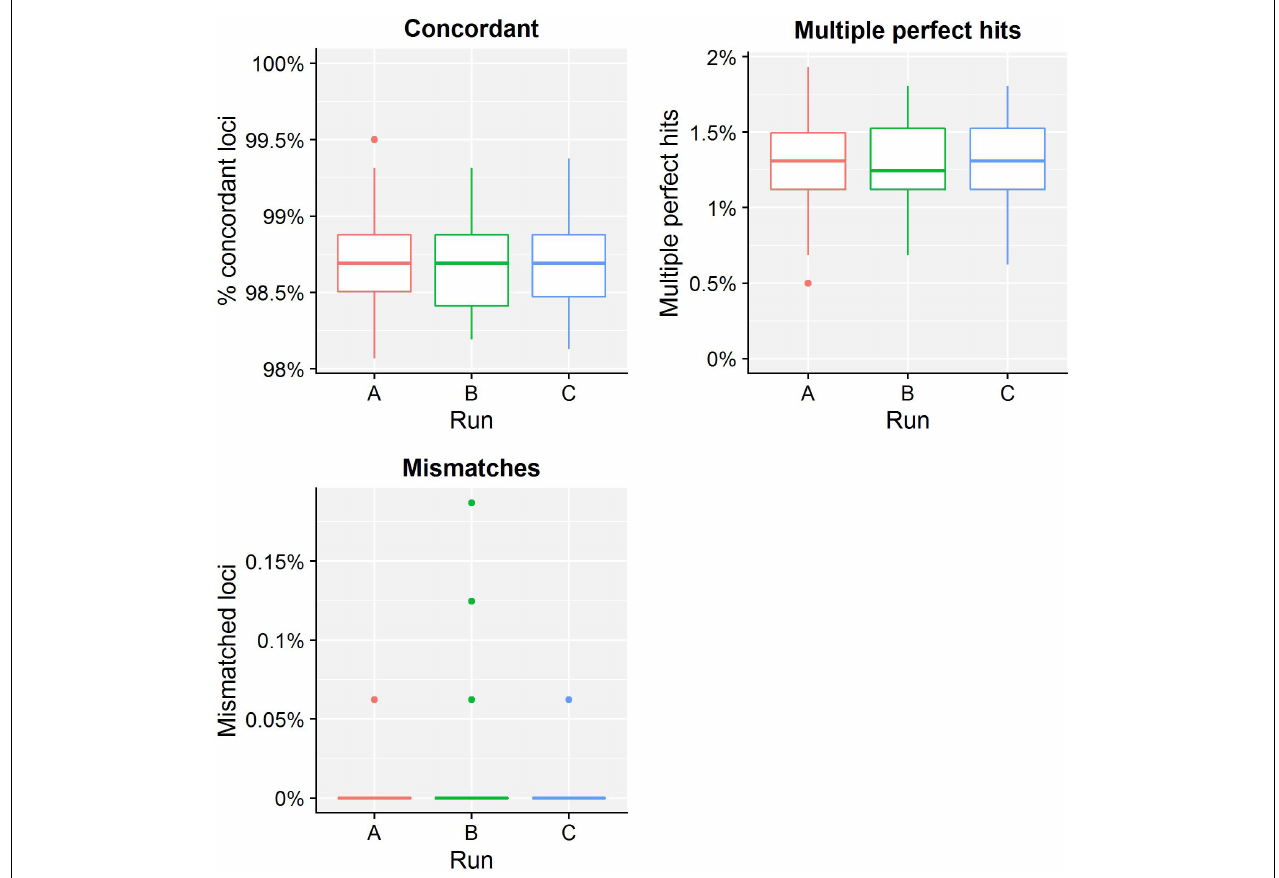
FIGURE 4 | Tool standard results of the sequence typing assay for the core validation dataset. The abscissa depicts the sequencing run, while the ordinate represents the percentages of cgMLST loci as indicated by the title above each graph. Each sequencing run is presented as a boxplot based on 67 samples (see the legend of Figure 2 for a brief explanation). The upper left graph depicts the percentage of concordant cgMLST loci, i.e., where our workflow identified the same allele as the tool standard, which were classified as TPs. Note that the ordinate starts at 98% instead of 0% to enable illustrating the results more clearly. All other cases were classified as FNs, and encompass two categories. First, the upper right graph depicts the percentage of cgMLST loci for which our workflow identified multiple perfect hits, of which at least one corresponded to the tool standard but was reported differently. Second, the lower left graph depicts the percentage of cgMLST loci for which our workflow detected a different allele compared to the tool standard. Most FNs are therefore explained by a different manner of handling multiple perfect hits, and only a small minority are due to an actual mismatch between our workflow and the tool standard. Furthermore, upon closer inspection, these mismatches were due to an artifact of the reference tool used for the tool standard that has been resolved in the meantime (see Supplementary Figure S2 ). See also Supplementary Table S11 for detailed values for all samples and